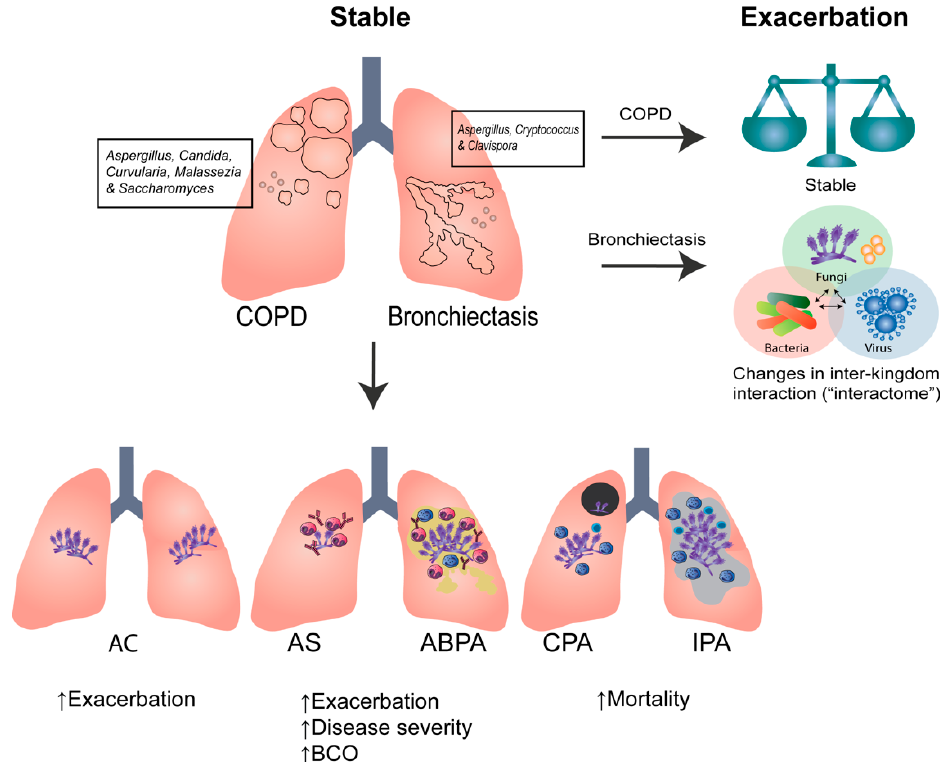
Figure 1. Summary of the pulmonary mycobiome during the stable state and exacerbations in COPD and bronchiectasis, including their association with Aspergillus -associated conditions and their clinical consequence. AC: Aspergillus colonization, AS: Aspergillus sensitization, ABPA: allergic bronchopulmonary aspergillosis, CPA: chronic pulmonary aspergillosis, IPA: invasive pulmonary aspergillosis, BCO: bronchiectasis-COPD overlap, COPD: chronic obstructive pulmonary disease, ↑ : increased.